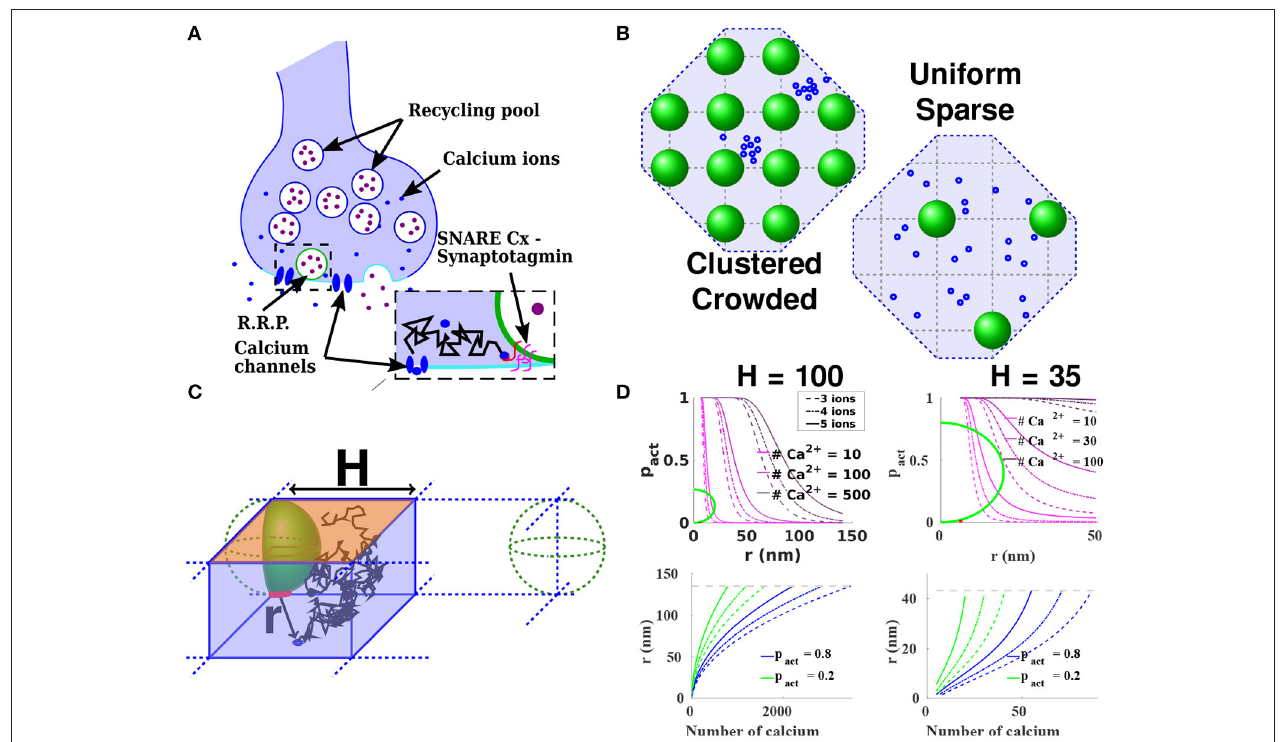
FIGURE 1 | Estimating the release probability. (A) Functional organization of the presynaptic terminal. An incoming action potential leads to the opening of voltage gated calcium channels (blue) located at the AZ (light blue). The consecutive entry of calcium ions (orange) triggers the fusion of docked vesicles (green) with the synaptic membrane, and the liberation of neurotransmitters (purple) in the synaptic cleft. The binding of neurotransmitters to specific receptors located in the post-synaptic terminal triggers the conversion of the chemical signal into an electrical signal in the post-synaptic neuron. (B) Model of the AZ organization. Vesicles (green) are regularly (left) or sparsely (right) distributed on a square lattice. Calcium channels (blue) can be clustered (left) or uniformly distributed (right) in the AZ. (C) Elementary 3-dimensional domain to compute the splitting probability for an ion starting in the bottom of the domain (blue circle representing a channel), to reach the target (red) before leaving the domain through the orange boundary. The other boundaries are reflecting. The vesicles are distributed on a square lattice of side 2 H . (D) (Top): Probability to find three, four, or five calcium ions (full, dashed and dotted lines respectively) underneath a vesicle, in the case of sparse vesicular distribution: H 100 nm (left) and in the case of crowding of vesicles at the AZ: H 35 nm (right). The relation depends on the initial number of calcium ions. The diameter of the = = pre-synaptic vesicles is fixed at R 40 nm (green), the diffusion coefficient for free calcium ions being D Ca 200 µ m 2 s − 1 . (Bottom): Maximal channels distance r to = = activate the vesicle with a probability p act 0.8 (blue) and 0.2 (green), when there are N initial ions, for H 100 nm (left) and H 35 nm (right). We fix the threshold to ≥ = = three, four, or five calcium ions. The gray dashed line represents the maximal distance to the vesicle in the elementary domain: √ 2 H